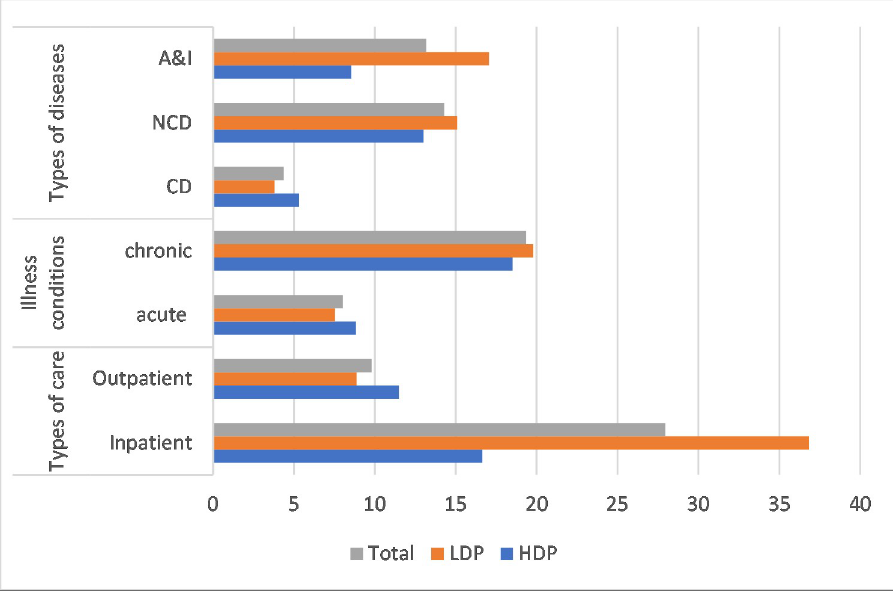
Fig 4. Impoverishment impact of OOP payments for healthcare by types of diseases, illness conditions and types of care in terms of relative poverty.